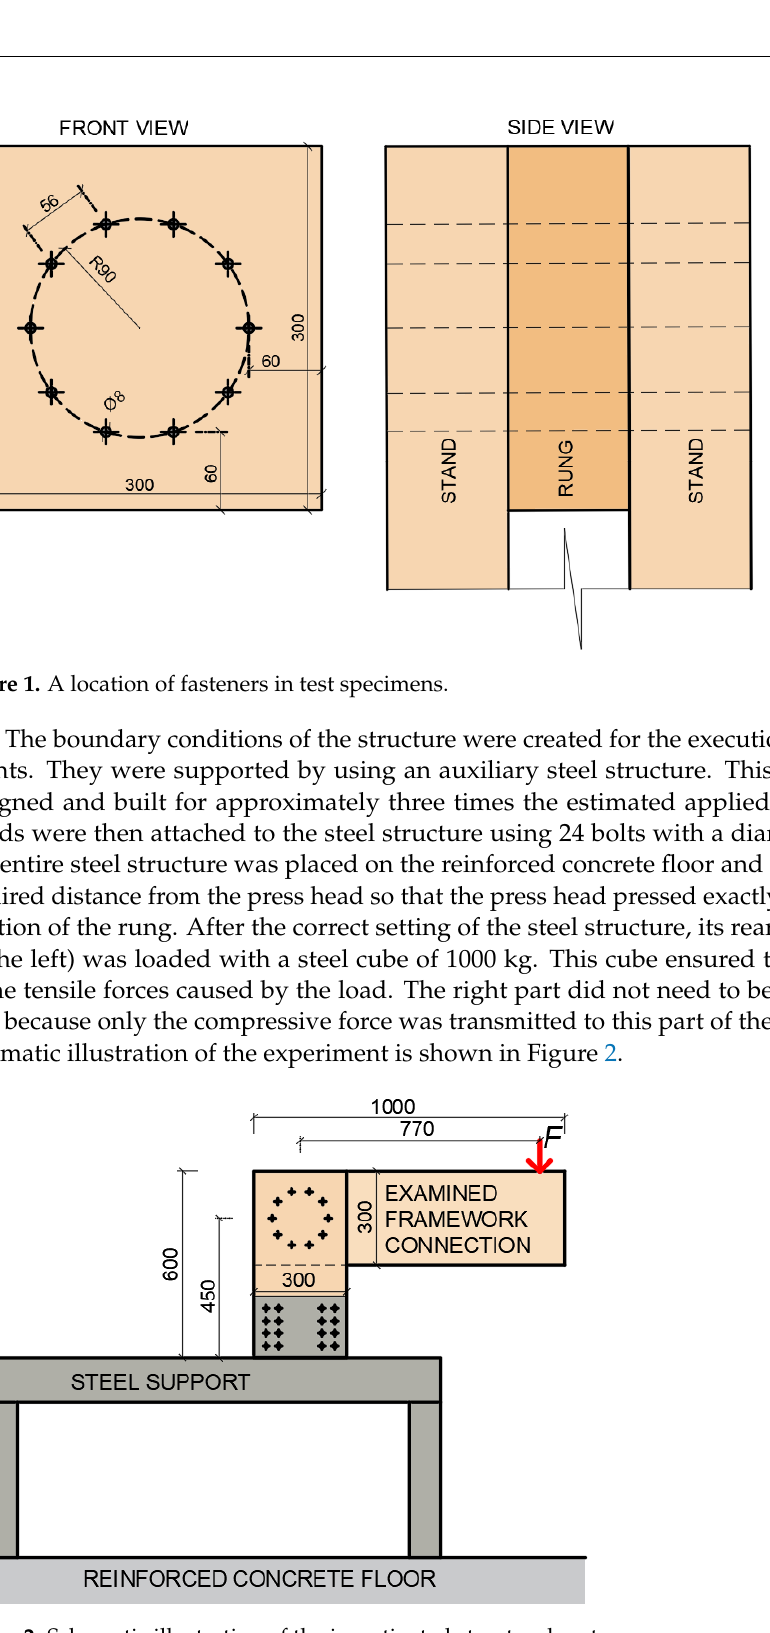
Figure 2. Schematic illustration of the investigated structural system.